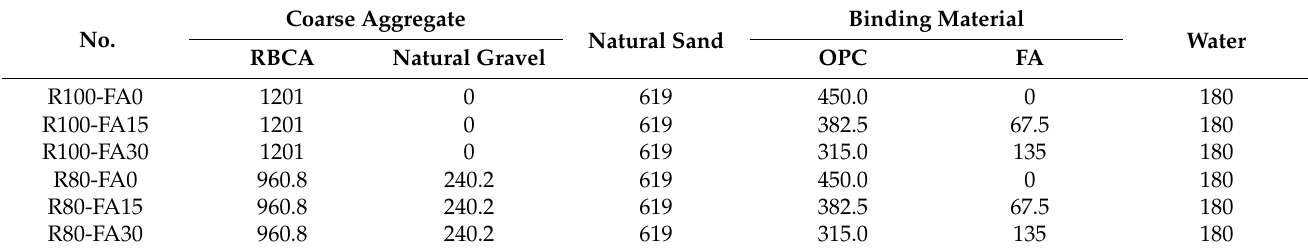
Table 3. Mix proportions of recycled concretes (kg/m 3